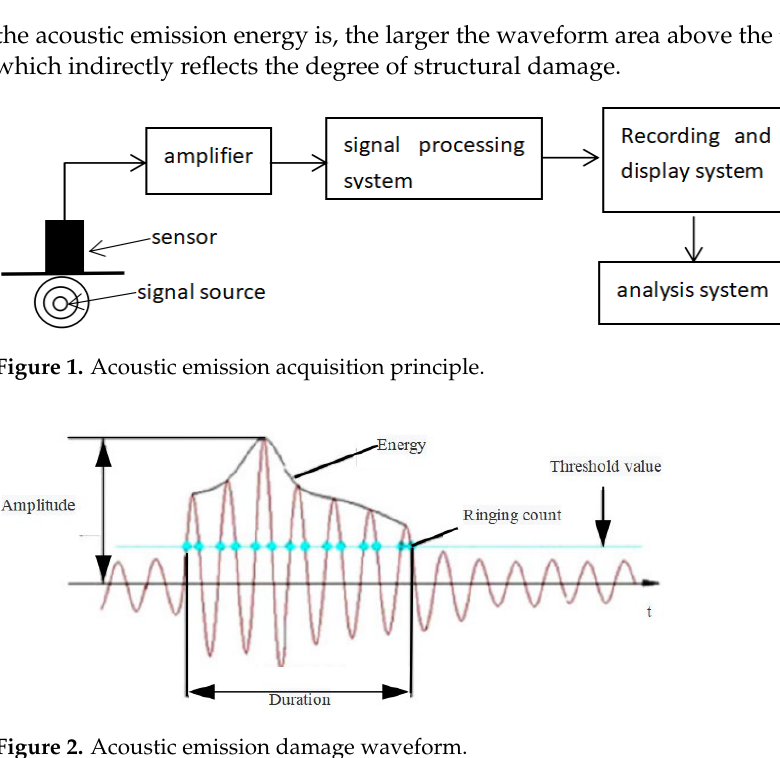
Figure 2. Acoustic emission damage waveform.